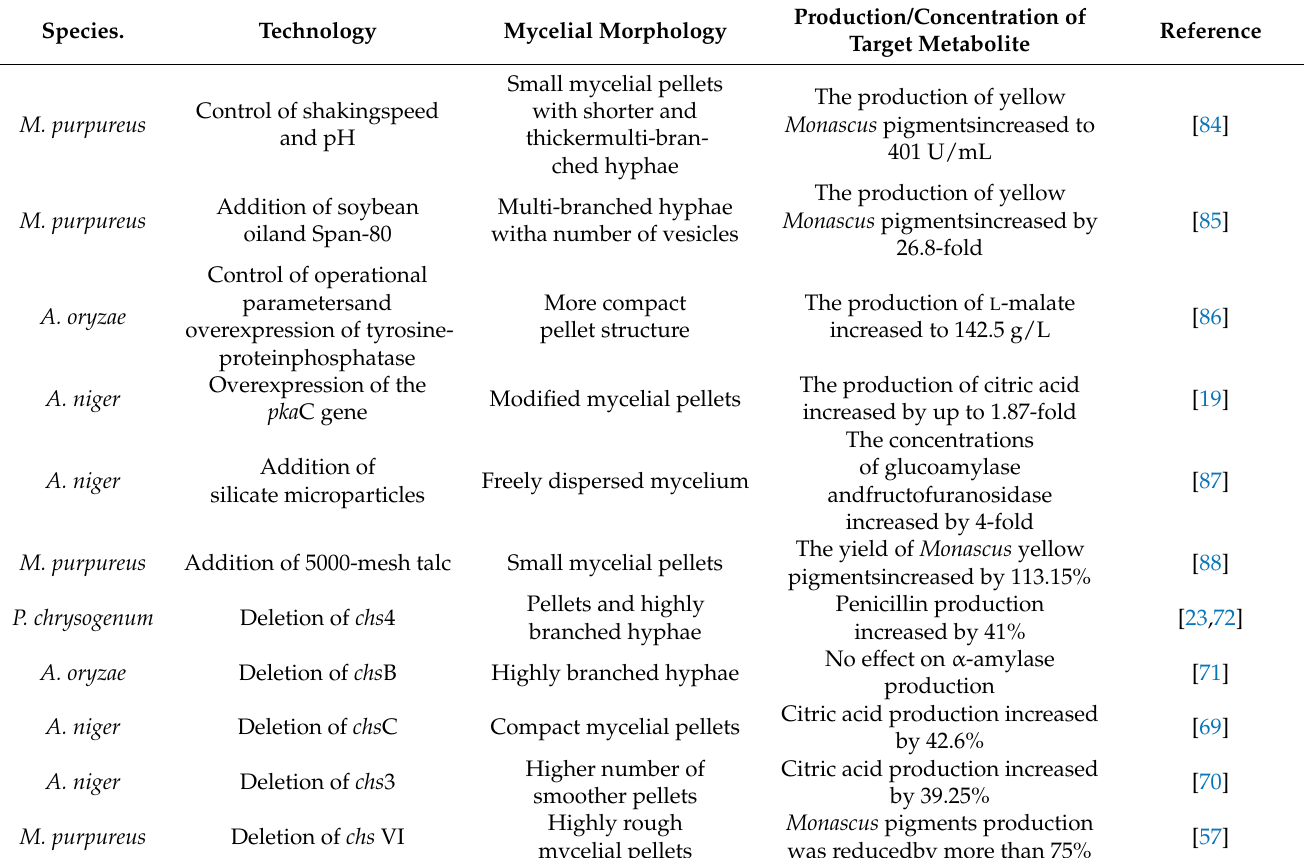
Table 2. A selection of the technologies applied in metabolic engineering of the morphology of filamentous fungi for enhancing the production of target